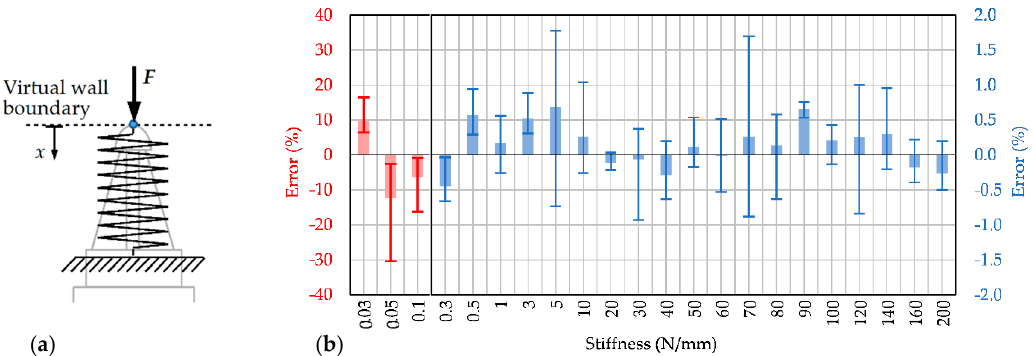
Figure 3. Stiffness fidelity: virtual wall model ( a ), percent error between the actual and commanded stiffnesses ( b ).